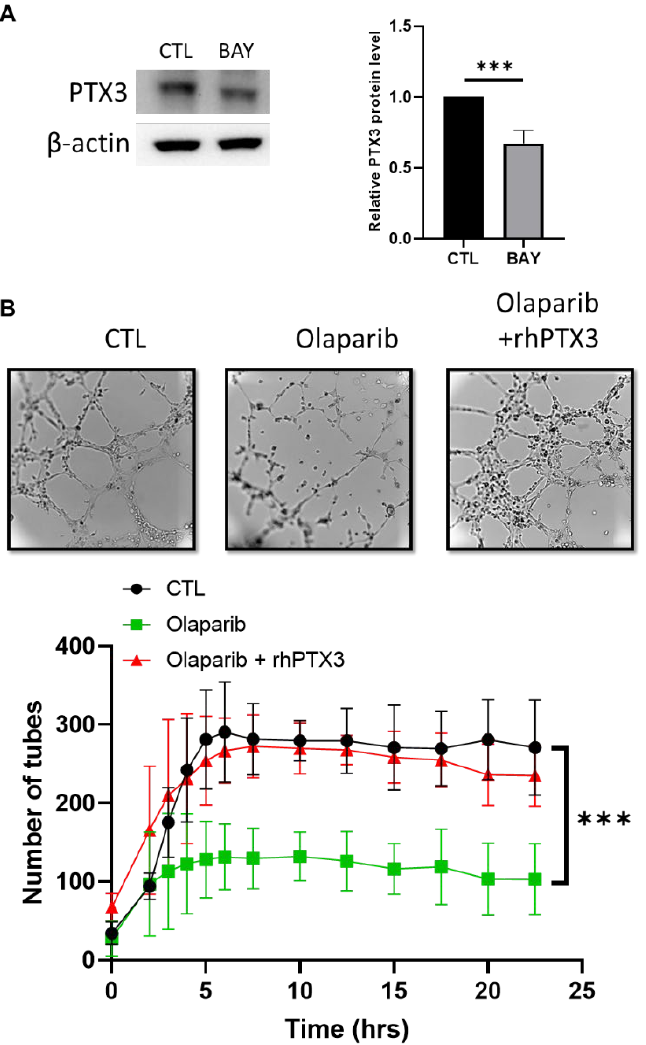
Figure 5. PTX3 reverses the PARPi effect on the VM formation. ( A ) Western blot analysis of PTX3 in the SUM159 cells after 24 h of treatment with BAY-11-7082 (2.5 µ M). ( B ) Cells were treated for 72 h with olaparib (20 µ M) and a human recombinant PTX3 was added for 24 h (1 µ g/mL). Representative pictures were taken at 24 h and the tube formations were quantified. Experiments were realized at least three times and the data were expressed as mean ± SEM. *** p <